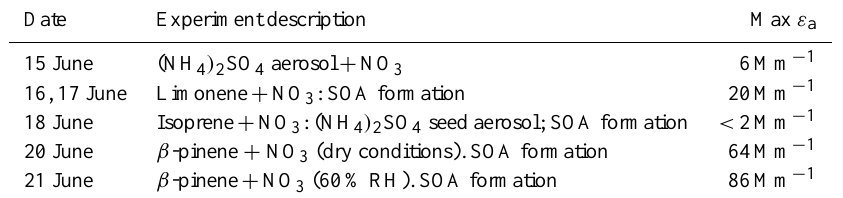
Table 2. Description of NO3Comp experiments, and indicative values of the maximum aerosol extinction coefficient, for days on which aerosols were added to or formed in the